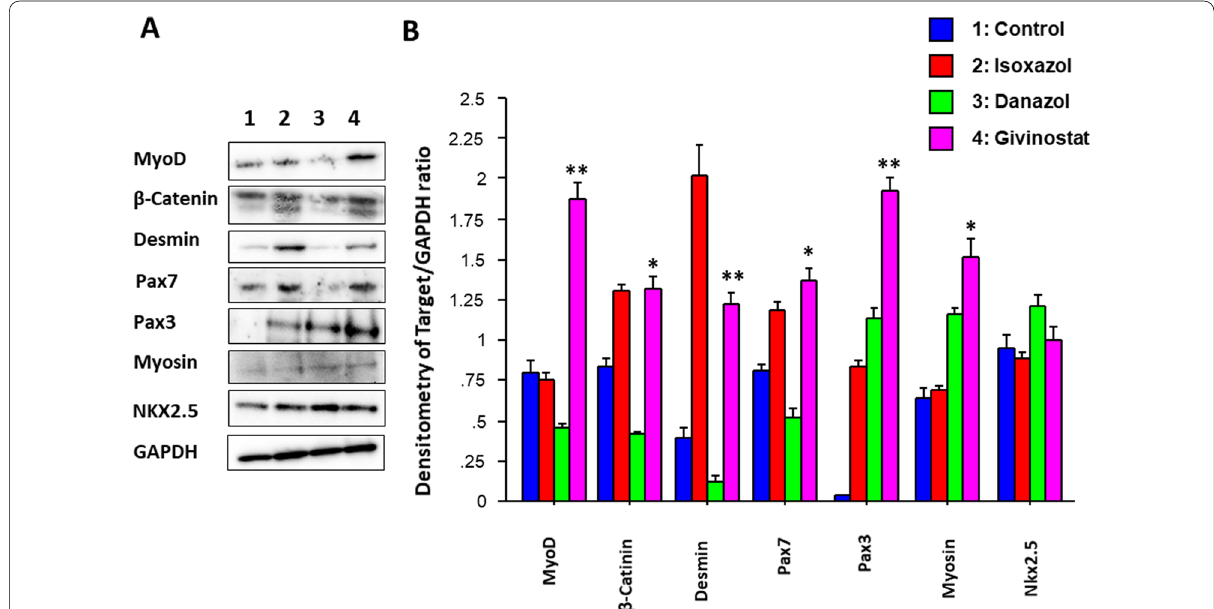
Fig. 3 Givinostat has dual expression of cardiac/skeletal myogenic proteins: GIV had dual cardiac myogenic progenitors and skeletal myogenic progenitor’s developments (Western Blot Assay) from hiPSCs versus ISX9, DAN and control after 7 days. Muscle protein expression included Pax3, Pax7, MyoD, myosin, desmin and β-catenin. Cardiac protein expression as Nkx2.5. Values are mean P- value 0.001, # P- value 0.0001 are = =